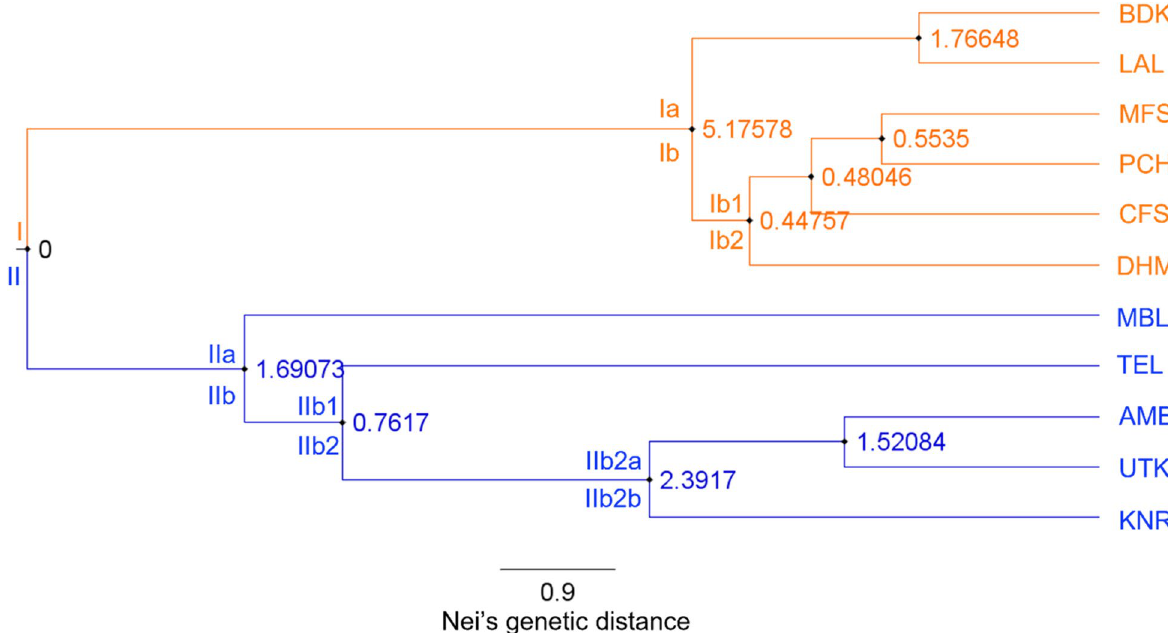
Fig. 2 UPGMA dendrogram showing relationships among 11 populations of G. sylvestre in India and values at nodes showing branch length. Population codes are as given in the Table